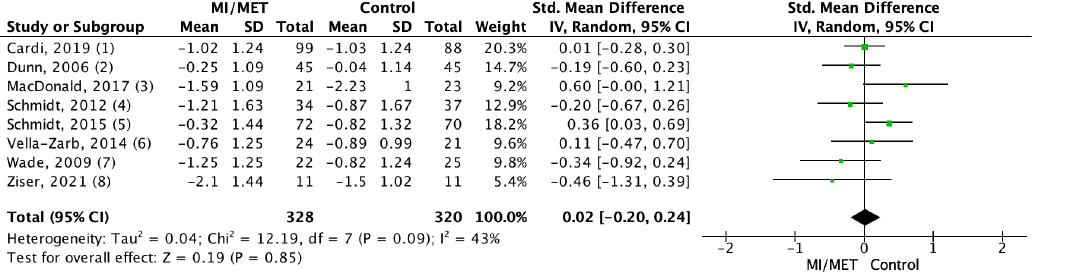
Figure 4. Forest plot displaying the pooled effect using the standardized mean difference (SMD) of motivational enhancement therapy/motivational interviewing (MET/MI) on motivation. Mean = motivation scores at post-intervention, SD = standard deviation.